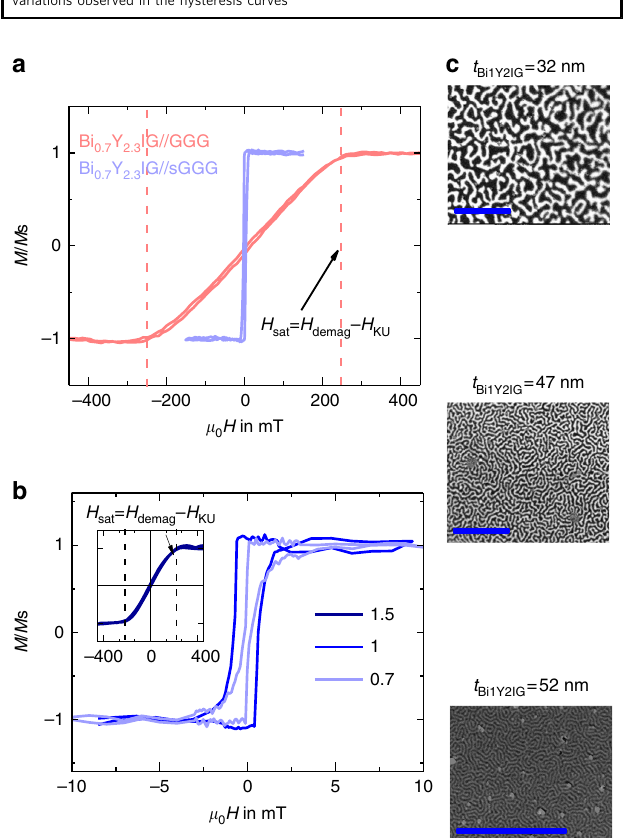
Fig. 2 Static magnetic properties. a Out-of-plane Kerr hysteresis loop performed in the polar mode for Bi 0.7 Y 2.3 IG fi lms grown on the two substrates: GGG and sGGG. b Same measurement for Bi x Y 3- x IG grown on sGGG with the three different Bi doping ( x = 0.7, 1, and 1.5). Bi 0.7 Y 2.3 IG//GGG is in-plane magnetized whereas perpendicular magnetic anisotropy (PMA) occurs for x = 0.7 and x = 1 fi lms grown on sGGG: square shaped loops with low saturation fi eld ( µ 0 H sat about 2.5mT) are observed. Those two fi lms are